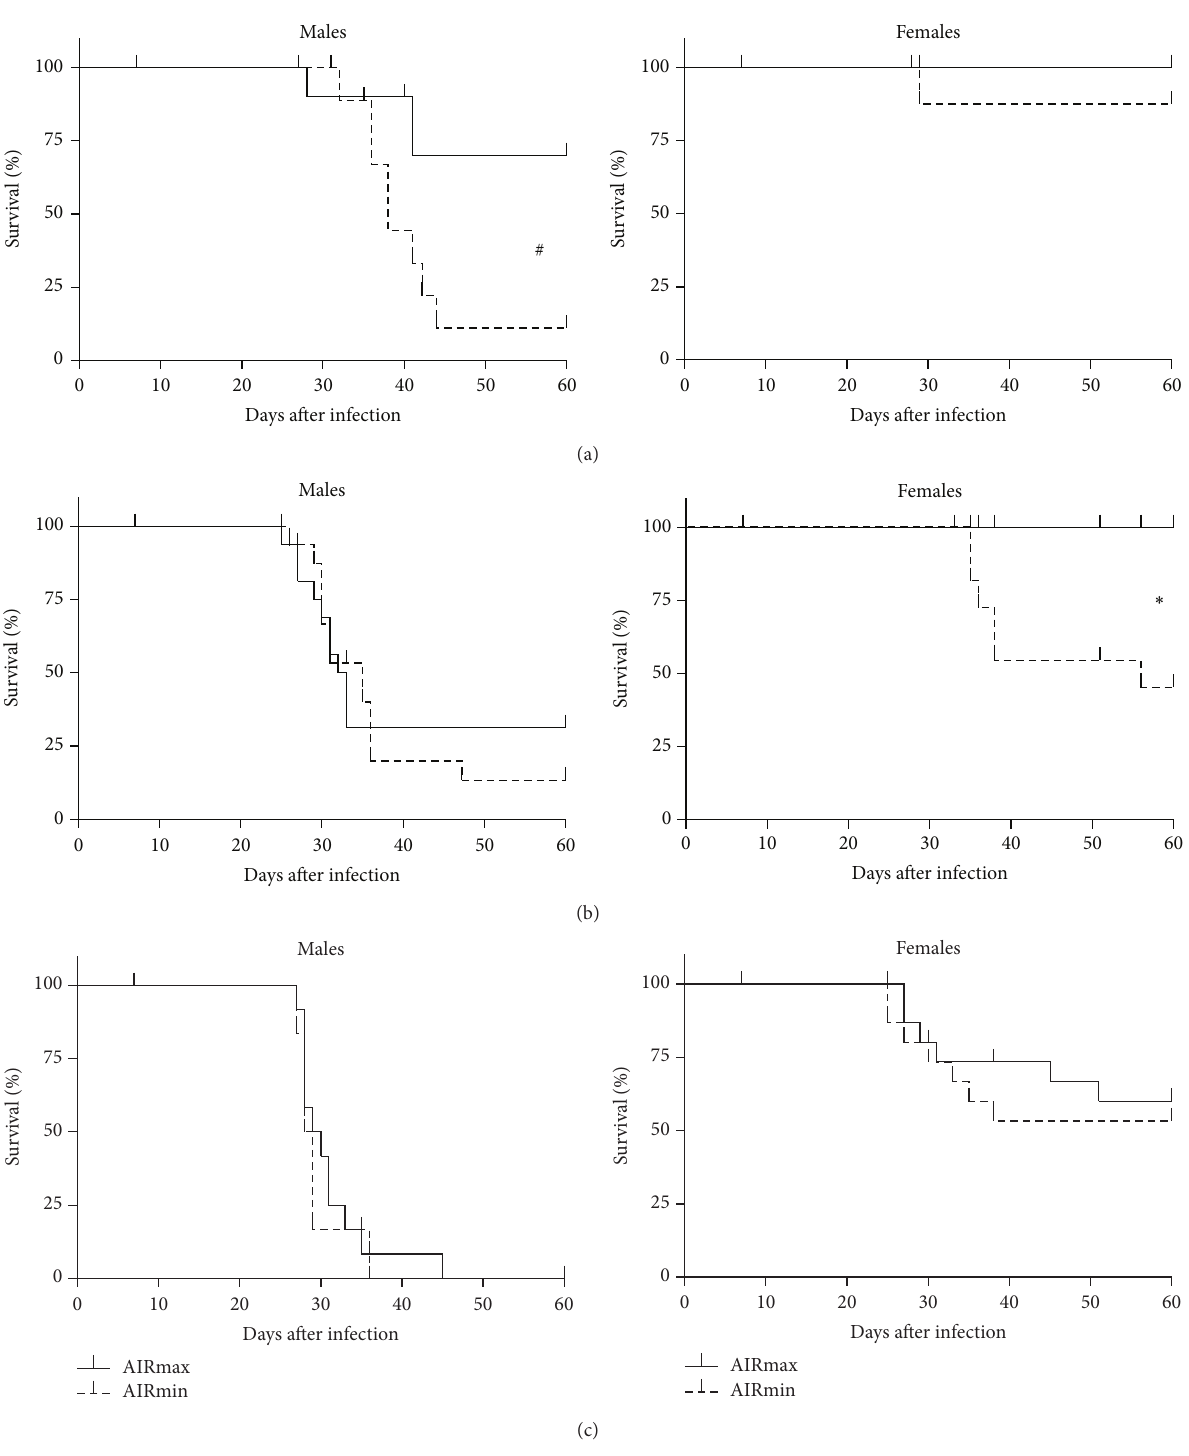
Figure 1: Survival curves of AIR mice after T. cruzi infection. AIRmax and AIRmin mice were infected (s.c.) with 10 (a), 10 2 (b), or 10 3 (c) of CL strain trypomastigote forms. Interline differences evaluated by survival curve analyses of each group ( 𝑛 = 8 ) are indicated for males ( # 𝑃 = 0.04 ) and females ( ∗ 𝑃 = 0.003